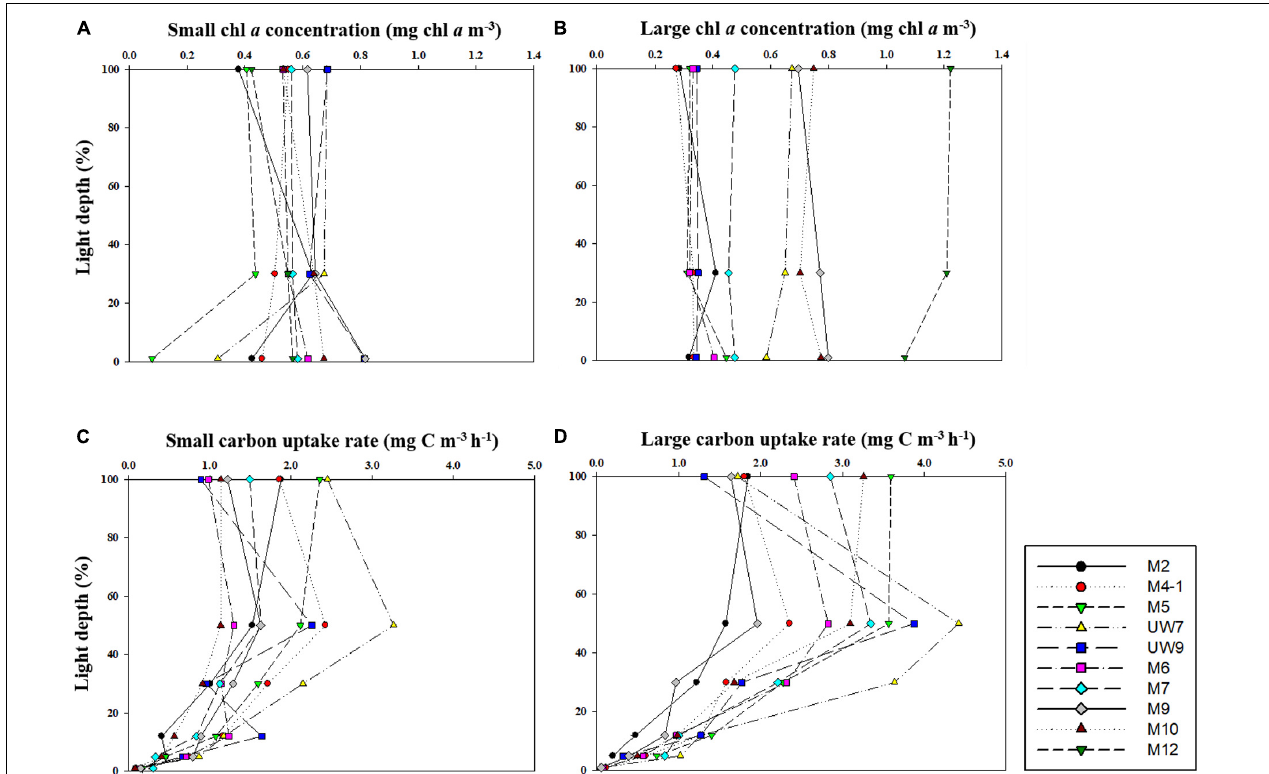
FIGURE 4 | Vertical distributions of chl a concentration for (A) small and (B) large size phytoplankton and carbon uptake rates for (C) small and (D) large size phytoplankton at different light depths in 2016.